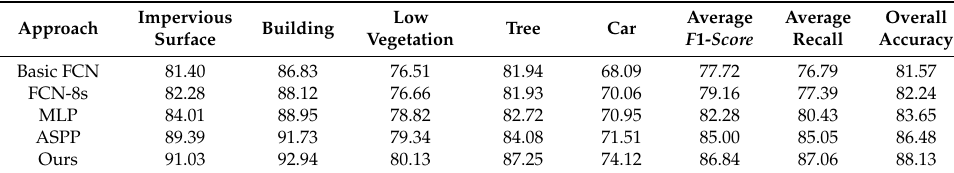
Table 2. Results of experiments on the Vaihingen dataset.